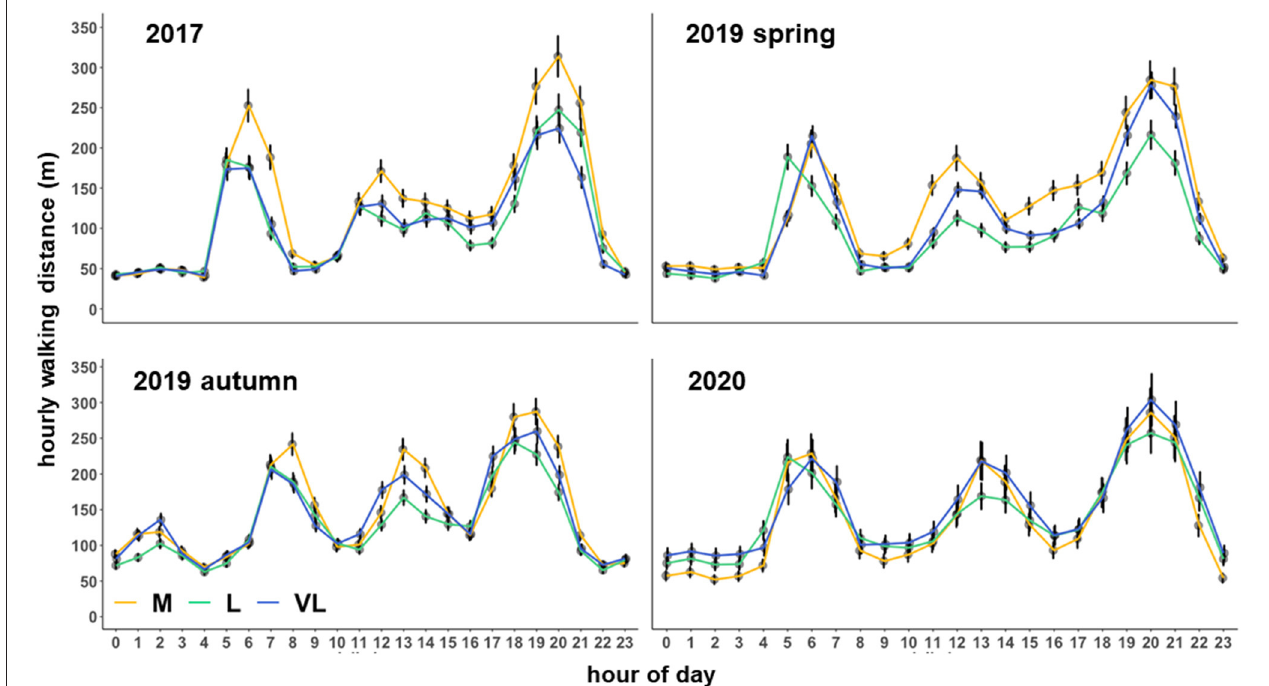
FIGURE 1 | Estimated means ( ± SE) of the average hourly walking distance (m) as influenced by the grazing period, grazing intensity and hour per day. M, moderate; L, lenient; VL, very lenient grazing